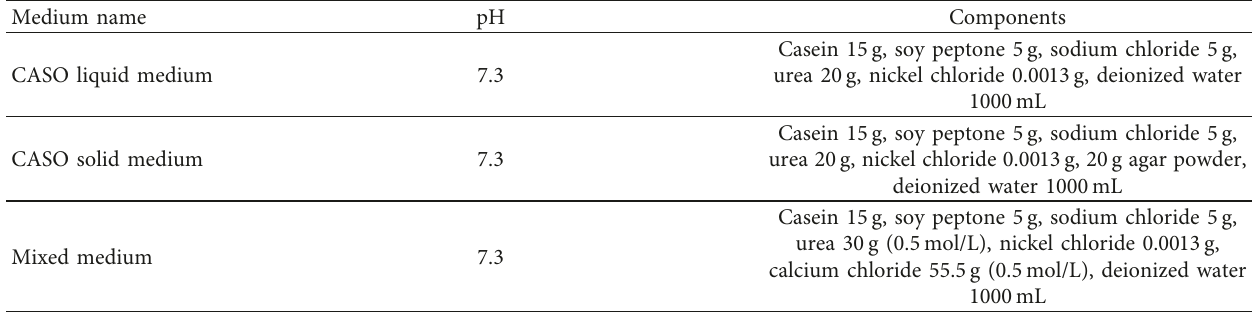
Table 1: Composition of culture medium used in the